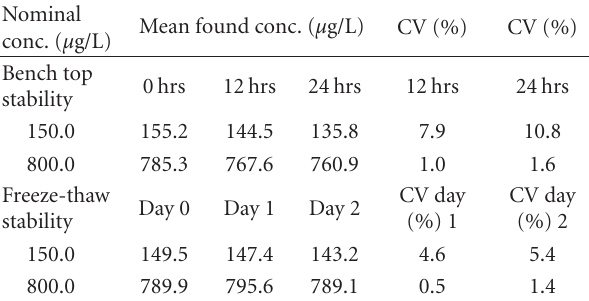
Table 3: Bench top and freeze-thaw stability of rimonabant ( n = 6). Nominal conc. ( µ